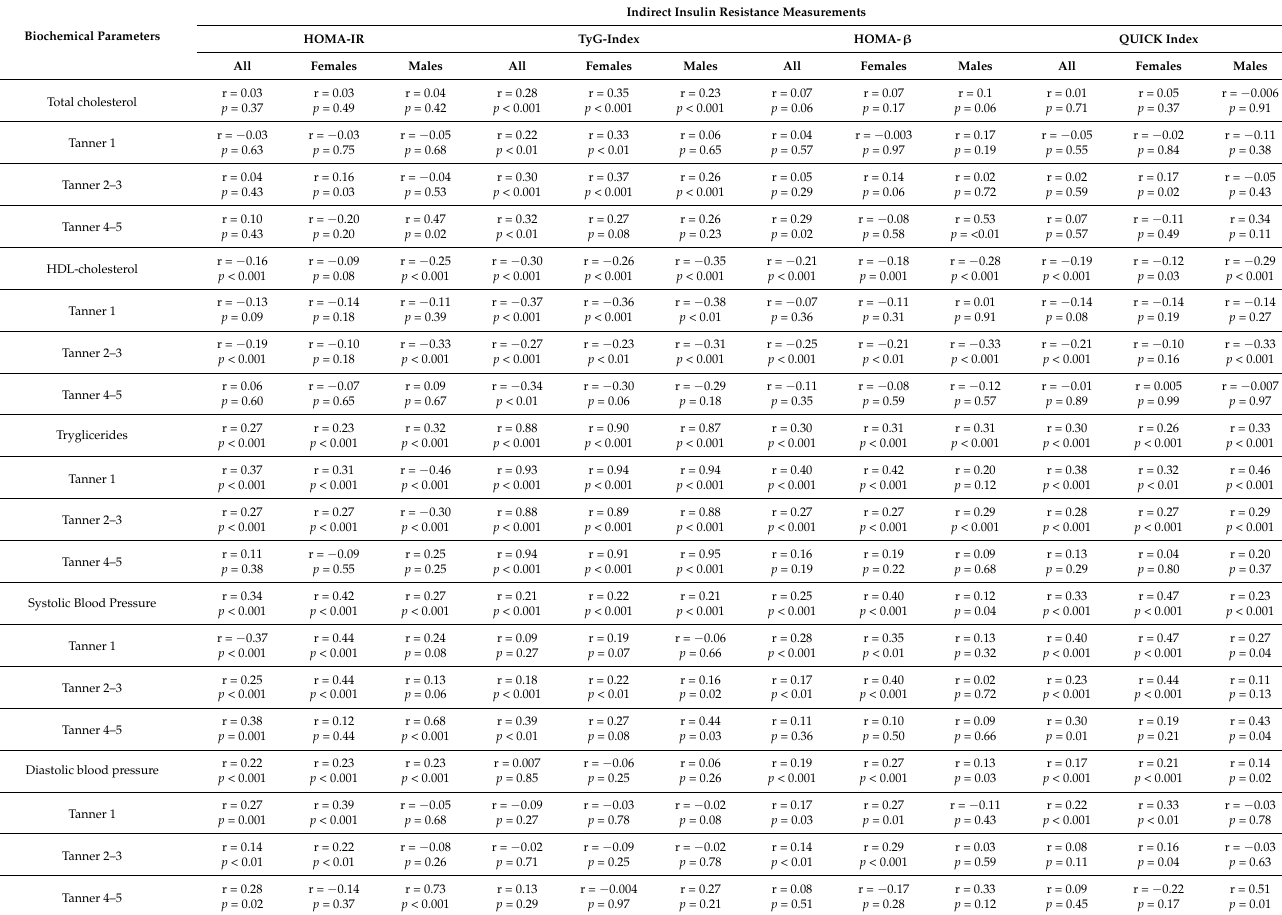
Table 3. Correlation between insulin resistance measurements and biochemical